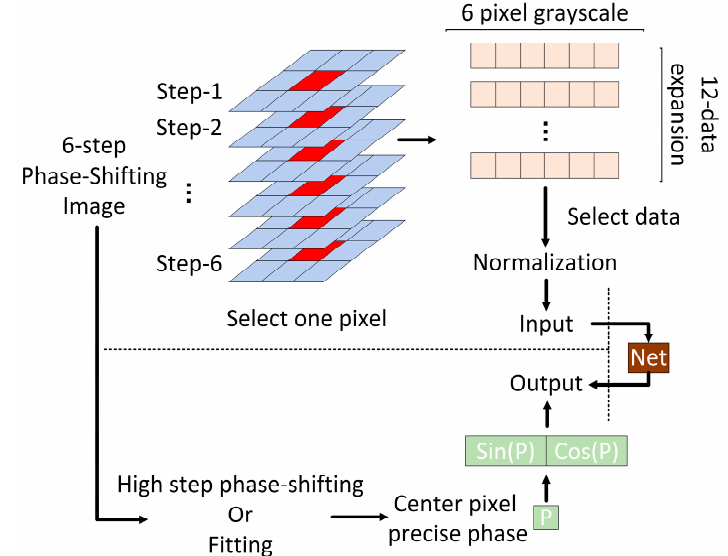
Figure 3. Comparison of the continuity of different output modes.